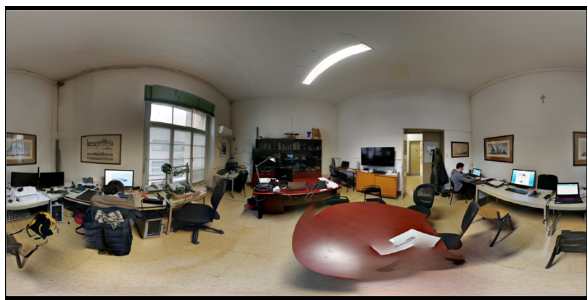
Figure 3. 360-degree spherical